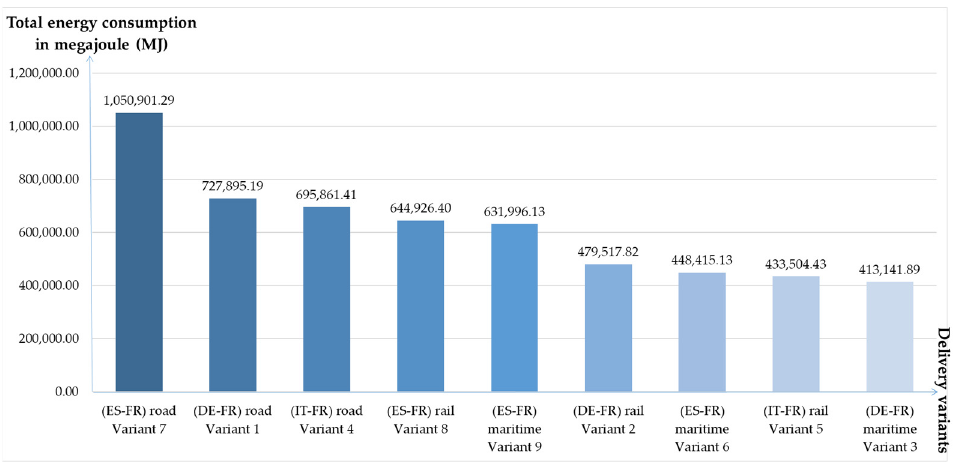
Figure 3. Total energy consumption of delivery variants. Source: own study based on the application of SolidWorks.